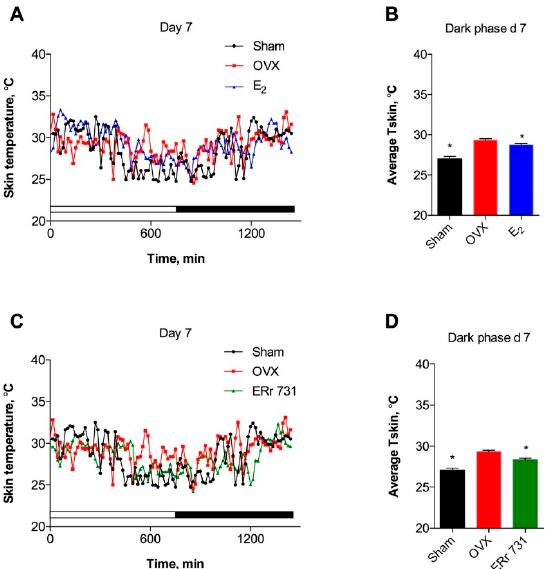
Figure 3. Effects of ERr 731 and E 2 on T skin persisted for one week of treatment. ( A ) Recordings of OVX controls (red) show circadian rhythm and increased T skin as compared to intact (Sham, black) animals, while E 2 treatment (blue) is associated with decreased T skin on day 7; ( B ) Average T skin is significantly increased in OVX rats and reduced following E 2 treatment in the dark phase of day 7; ( C ) Recordings of decreased T skin following ERr 731 treatment (green) on day 7; ( D ) Average T skin is significantly reduced in ERr 731-treated rats in the dark phase of day 7. Data are the mean ± SEM ( n = 6), * p < 0.05 vs. OVX control.